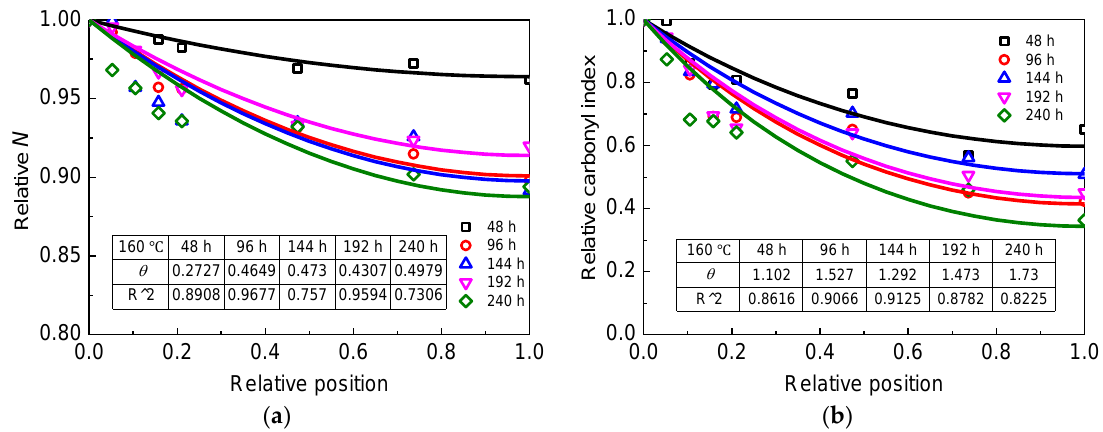
Figure 10. ( a ) Relative N of aged XLPE samples; ( b ) relative carbonyl index of aged XLPE samples. Dots are measured data points and lines are fitted results using Equation (5).